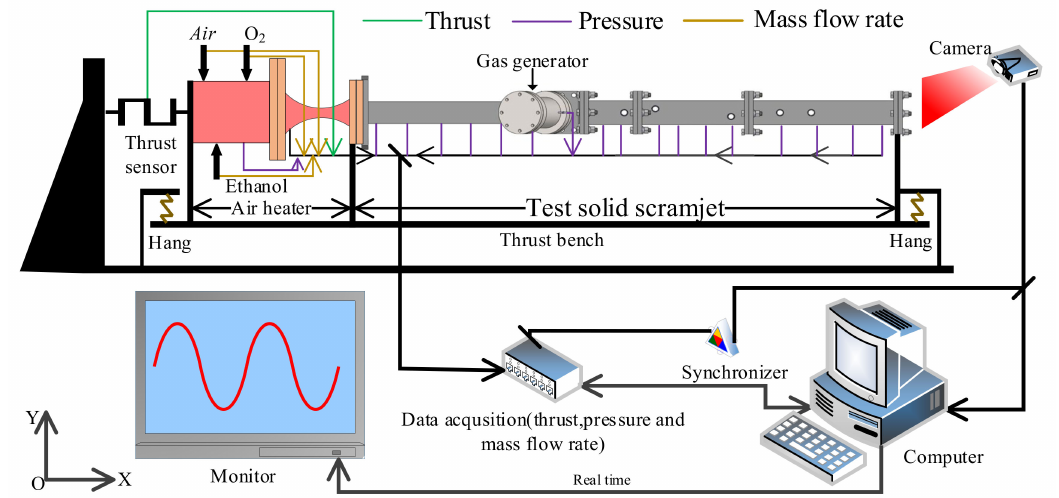
Figure 3. Schematic of the direct-connect test experiment platform. During the test, three types of parameters were collected: pressure, thrust, and mass flow. The thrust is measured by a thrust sensor (range 0~3 KN, error ± 0.1%). The pressures at the heater and gas generator are measured by high-pressure sensors (range 0~6 MPa, error ± 0.5%). Due to the low pressure of the scramjet combustor, a low-pressure sensor (range 0~1 MPa, error ± 0.5%) is used there. The mass flow rate of each component of the air heater is measured by turbine flowmeters with different ranges and an error of ± 0.2%. To ensure the safety of the test, the test process is controlled by the time sequence set in advance, as shown in Table